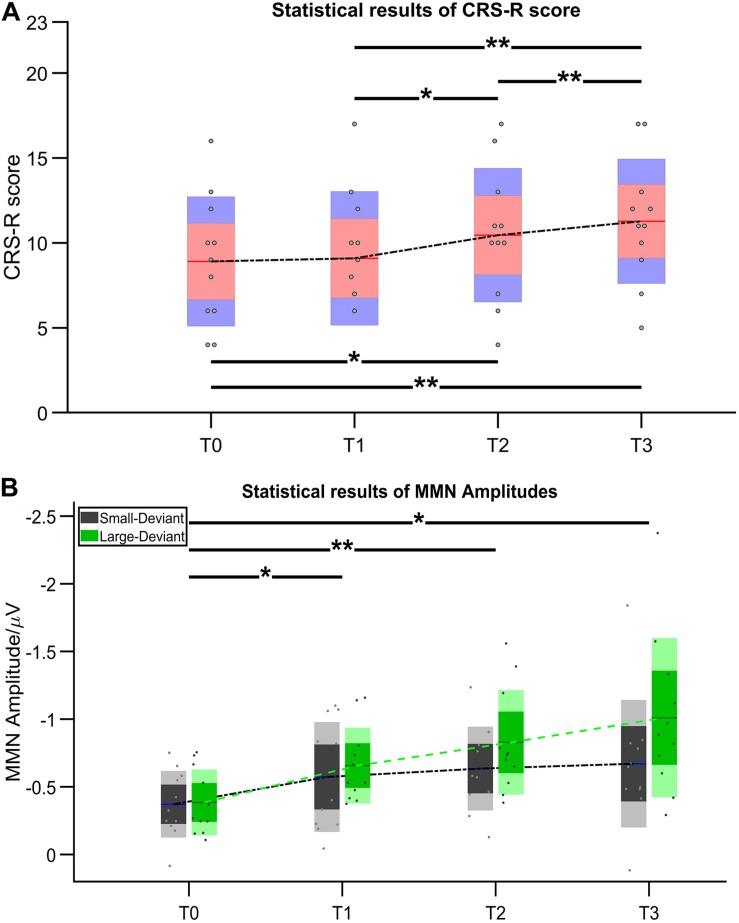
Statistical results of (A) CRS-R score and (B) MMN amplitude. Asterisk indicates significant differences (*p ≤ 0.05, **p ≤ 0.01).